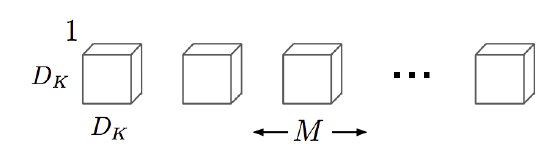
Figure 5. Depthwise convolution kernels